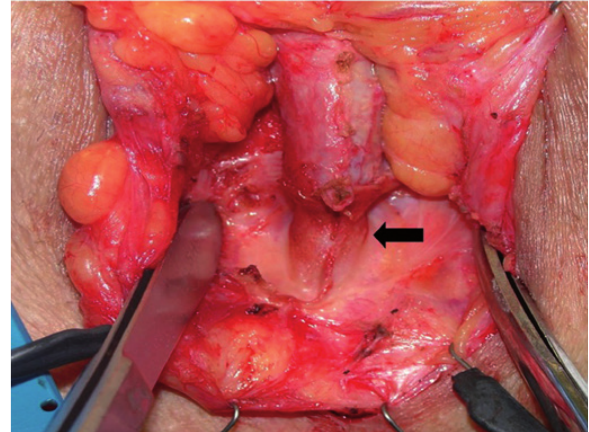
Figure 5 - urethral atrophy in a patient with previous As placement.